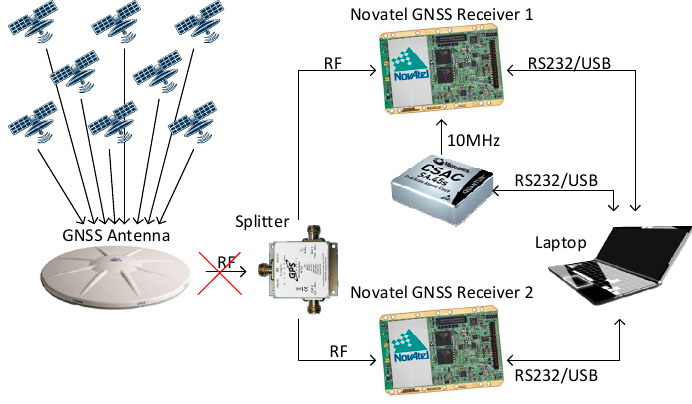
Figure 6. CSAC holdover measurements configuration.